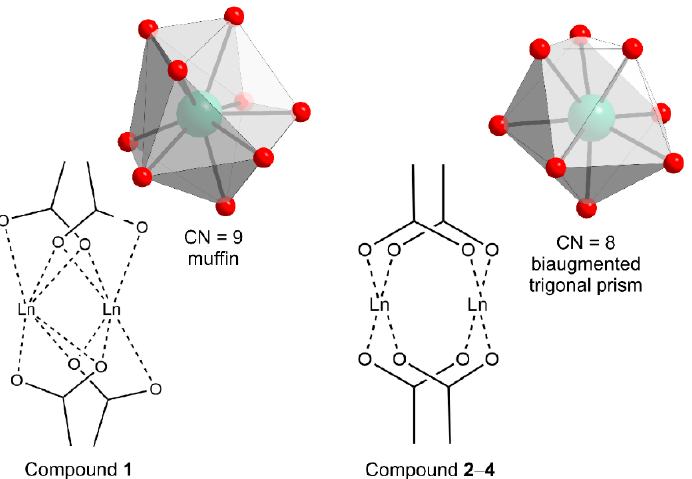
Figure 3. Schematic view of the paddle-wheel shaped cluster conforming the framework of each of the compounds. the